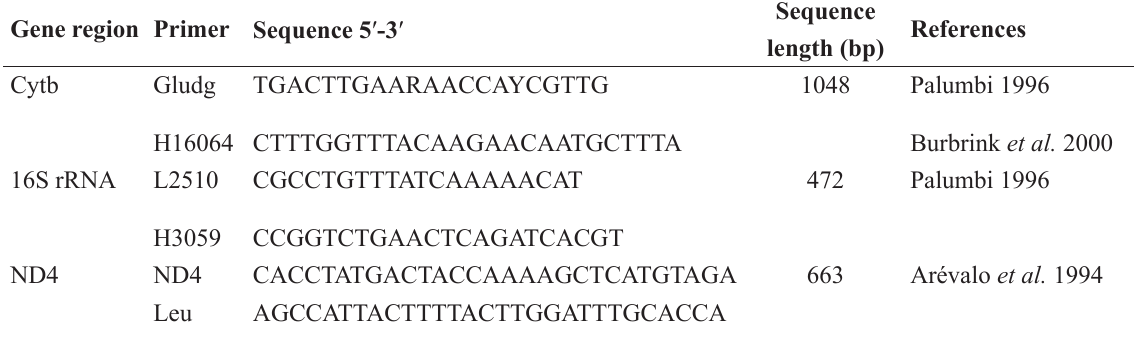
Table 1. Details of genes amplified, PCR primers used, DNA sequences length (in base pairs) and references for PCR protocols followed in this